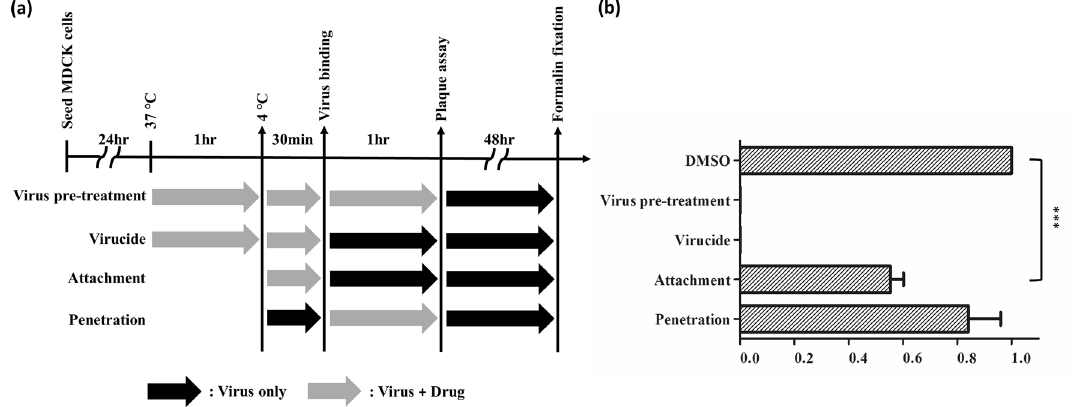
Figure 6. Time-of-addition assay. (a) Schematic representation of the antiviral activity of NSC47715 compound in different entry stages. (b) MDCK cells were infected with H1N1 (A/WSN/1933) and treated with NSC47715 compound at the concentration of EC 90(µM) at the indicated time according to the different strategy presented above. The values were presented as mean ± standard error of three independent experiments and were normalized to the values of DMSO solvent control. ***( p < 0.0001) shows there is a statistically different between NSC47715 and DMSO solvent control in the attachment